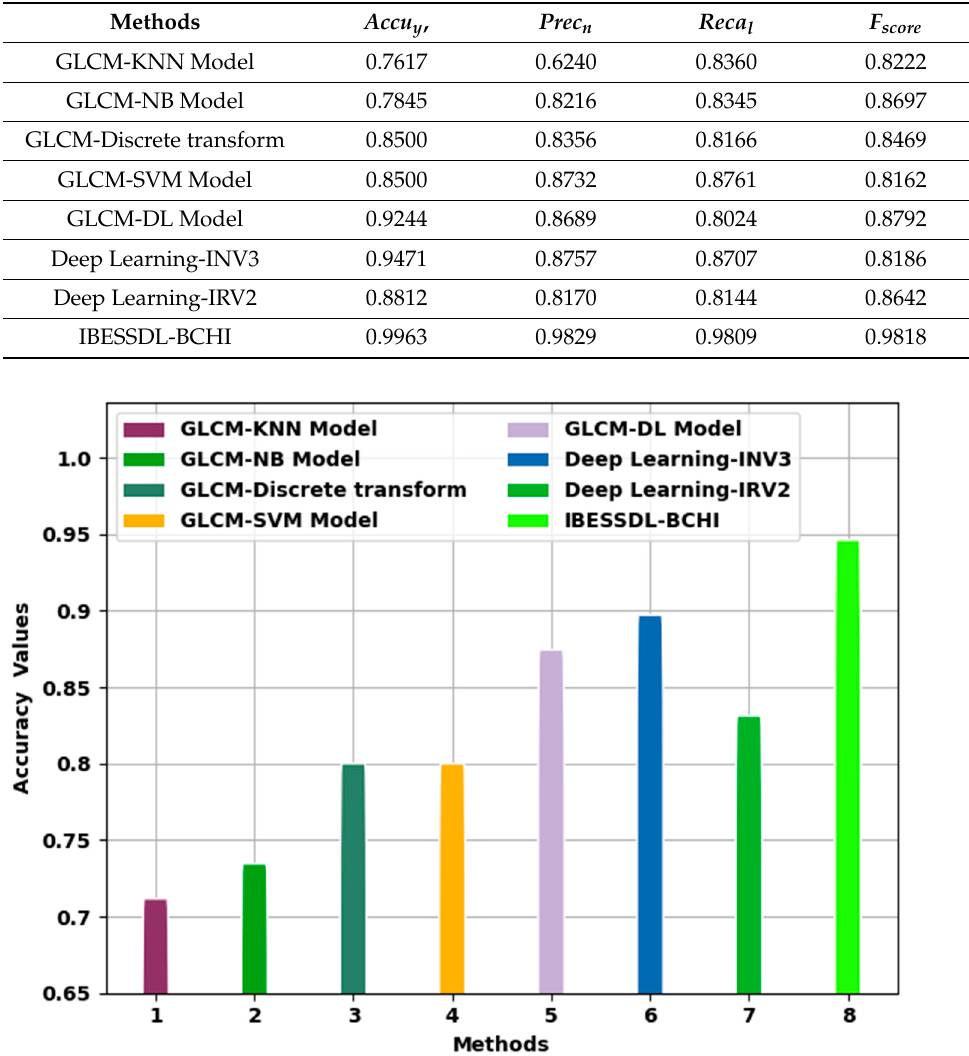
Figure 10. Accu y analysis results of the IBESSDL-BCHI approach and other existing Figure 10. 𝐴𝑐𝑐𝑢 (cid:3052) analysis results of the IBESSDL-BCHI approach and other existing methodolo- gies.